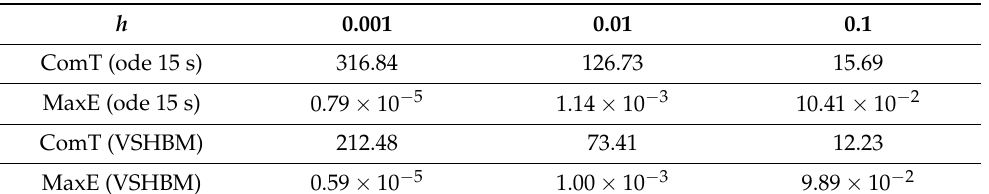
Table 6. Computation time and maximum error of the VSHBM using constant step h and eccentricity 1 − e = 0.0000001.